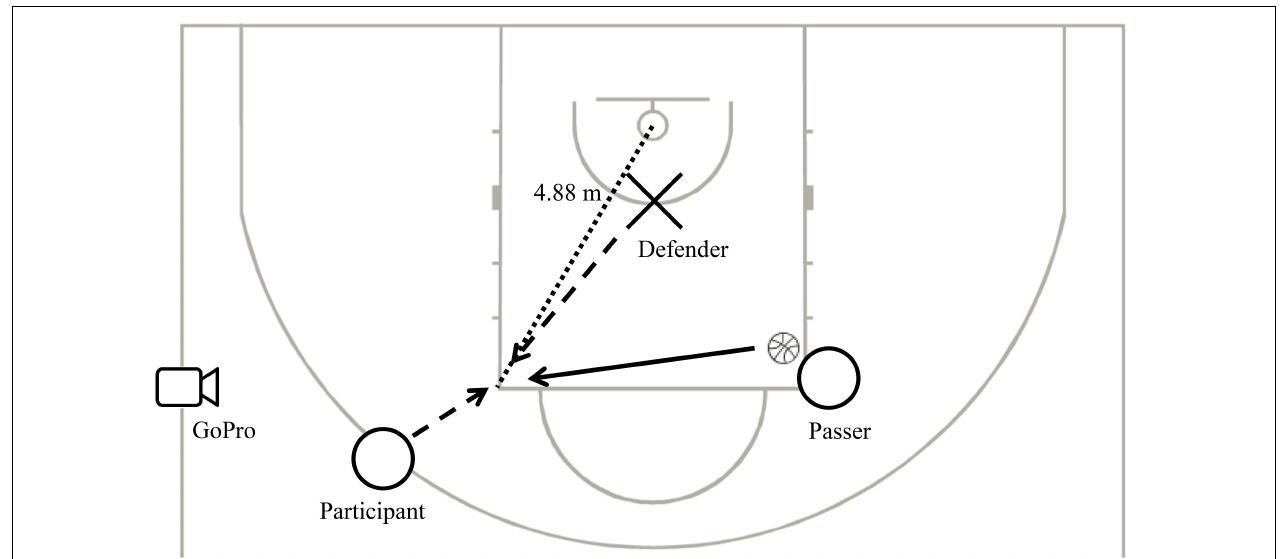
FIGURE 1 | Schematic top view of the experimental setup. Shooting from the left side is depicted. Participant (the shooter) steps in and receives the ball from the passer and takes a shot. In the contested condition, the defender (cross) steps in toward the participant to contest the shot. In the uncontested condition the defender stays in her original